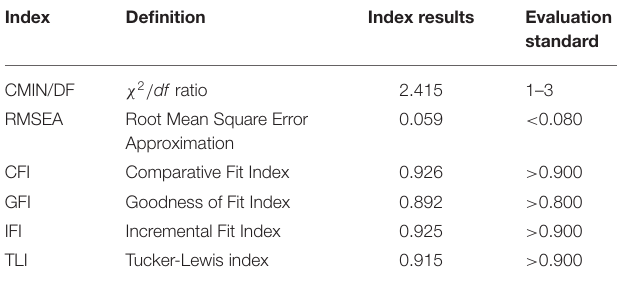
TABLE 5 | Goodness of fit